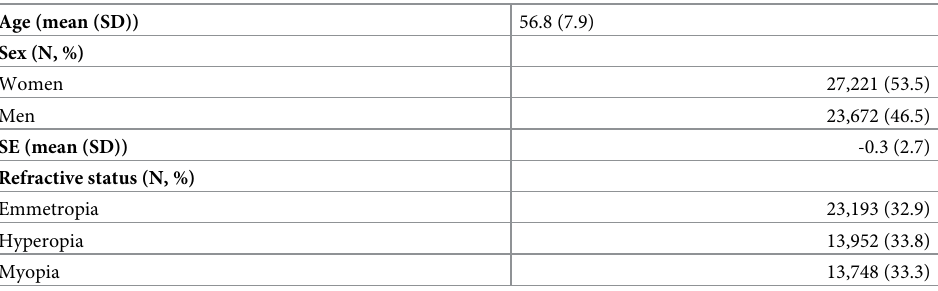
The refractive status was determined based on the measured spherical equivalent and which, for descriptive purposes, we are defining as Emmetropia (spherical equivalent in the range of -1.0 D +1.0 D), myopia ( � -1.0 D) and hyperopia ( � +1.0D).